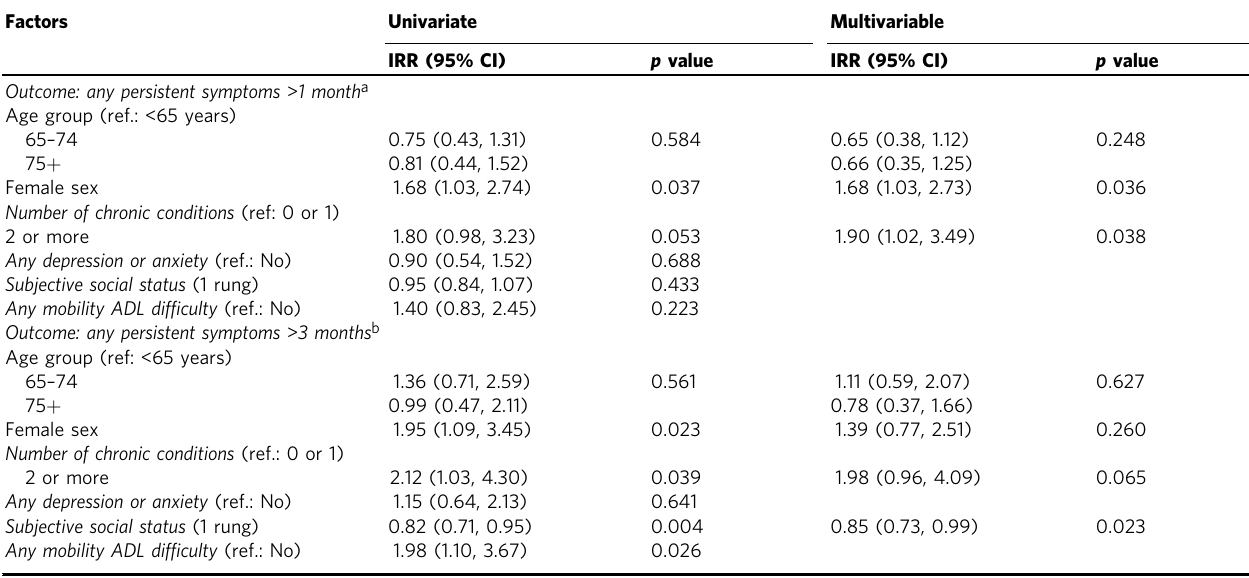
Table 2 Univariate and multivariable negative binomial regression analysis results assessing factors associated with >1 month and >3 month symptom persistence in participants with a positive COVID-19 test or physician